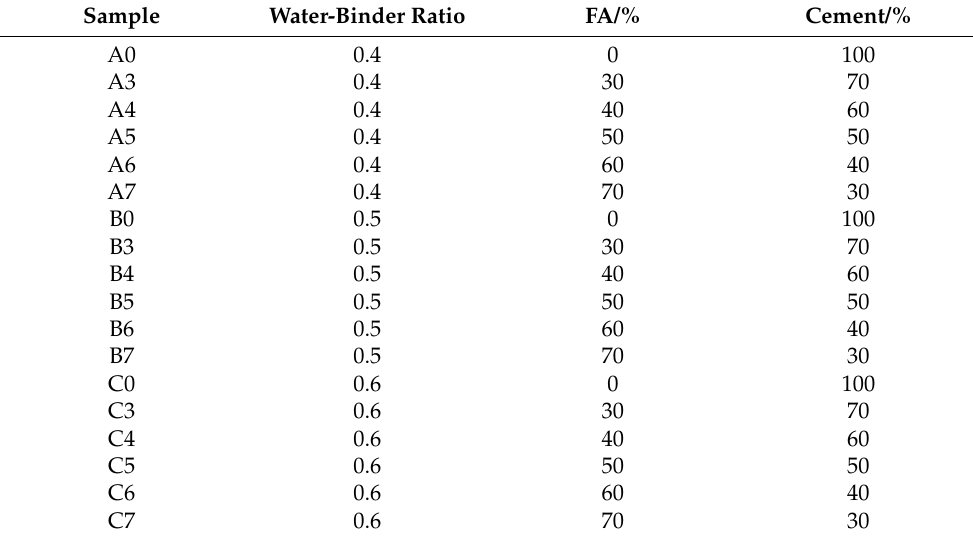
Table 2. Mix proportions of binder.